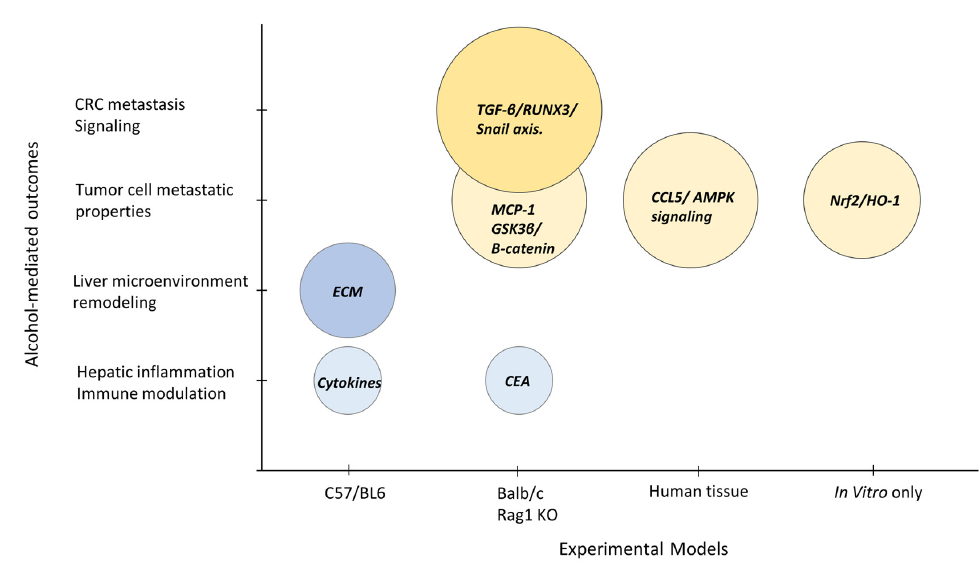
Figure 7. Summary of preclinical study results. Bubble plot reporting the study outcomes influenced by alcohol treatment in models using immunocompetent mice (C57/BL6) or immunodeficient mouse strains (Balb/c, Rag1 KO mice); human biopsy tissue; or in vitro only cell culture studies. The prometastatic pathways identified are highlighted for the alcohol ‐ affected liver microenvironment (blue bubbles) or CRC tumor cell behavior (yellow bubbles). The bubble size reflects the number of tumor cells assessed in each study. CCL5: C ‐ C chemokine ligand 5; CEA: carcinoembryonic antigen;